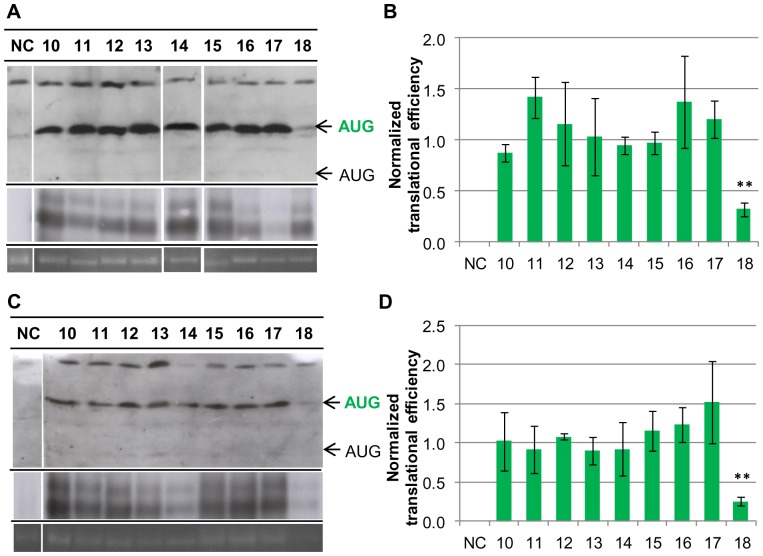
Translational efficiencies of the consecutive SD mutant series at reduced growth rates.For the comparative analysis of translational efficiencies H. volcanii cultures of pPK10-pPK18 and pNP10 negative control (NC) were grown to mid-exponential growth phase at the reduced temperature of 30°C (A, B) or with acetate as carbon and energy source (C, D). A. One representative example of three independent experiments is shown for a Western blot analysis (upper panel), a Northern blot analysis (middle panel), and the 16S rRNA of an agarose gel used for normalization. The protein and transcript levels were analyzed as described in Experimental Procedures. The results are summarized in Table S3. B. Graphic representation of the normalized average translational efficiencies and their standard deviations (n = 3). C. One representative example of three independent experiments is shown for a Western blot analysis (upper panel), a Northern blot analysis (middle panel), and the 16S rRNA of an agarose gel used for normalization. The protein and transcript levels were analyzed as described in Experimental Procedures. The results are summarized in Table S4. D. Graphic representation of the normalized average translational efficiencies and their standard deviations (n = 3).